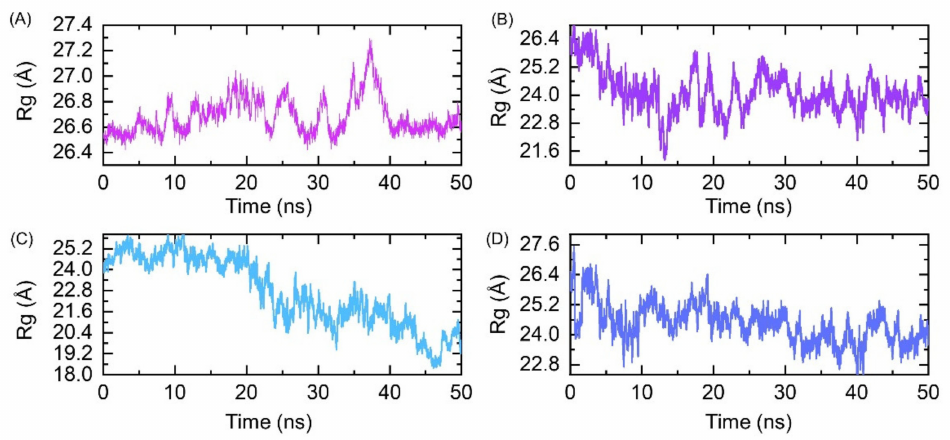
Figure 5. ( A ) Rg of the best hit 1. ( B ) Rg of the best hit 2. ( C ) Rg of the best hit 3. ( D ) Rg of the best hit 4.